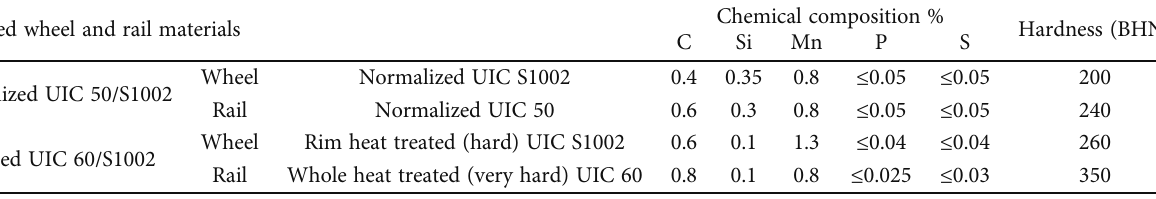
Table 2: Chemical composition of candidate rail and wheel materials.